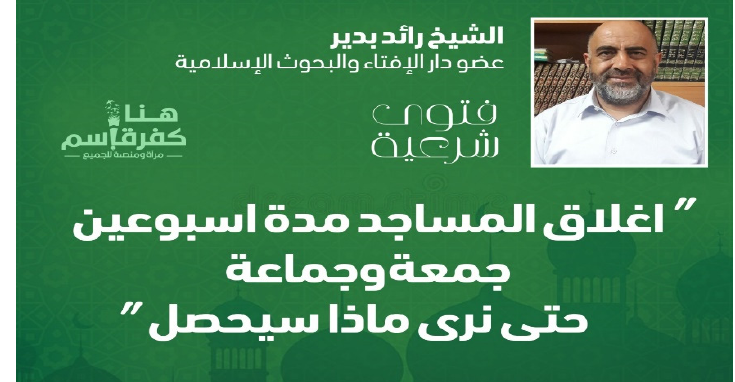
Figure 1. Announcement to Local Muslim Community on Mosque Closure. Image distributed by Sheikh Bad ī r, and shared directly with Author (1 April 2020).